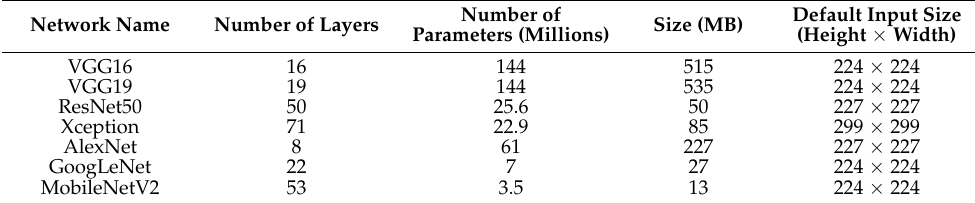
Table 3. Examples of commonly used pre-trained